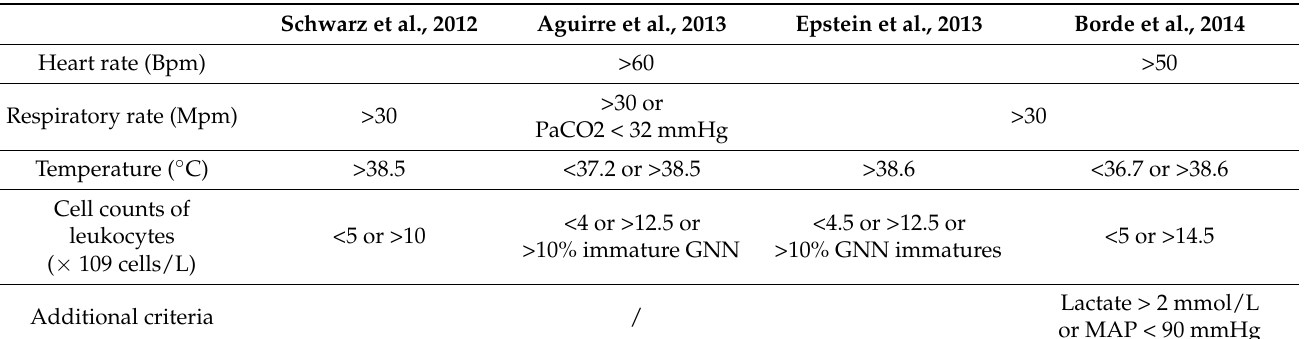
Table 3. Summary of the SIRS criteria used for adult horses in Schwarz et al., 2012; Aguirre et al.,